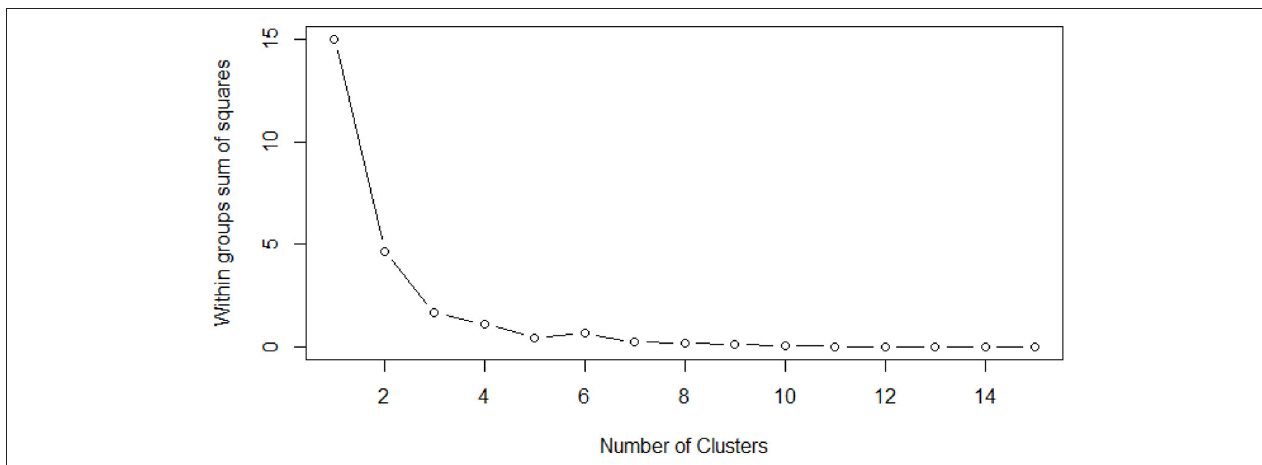
Naturalistic Green